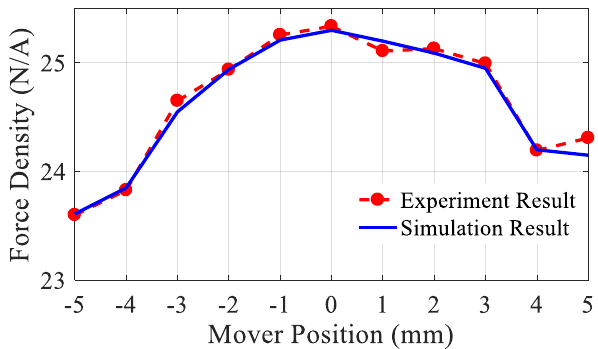
Figure 6. Force constant variations within stroke.